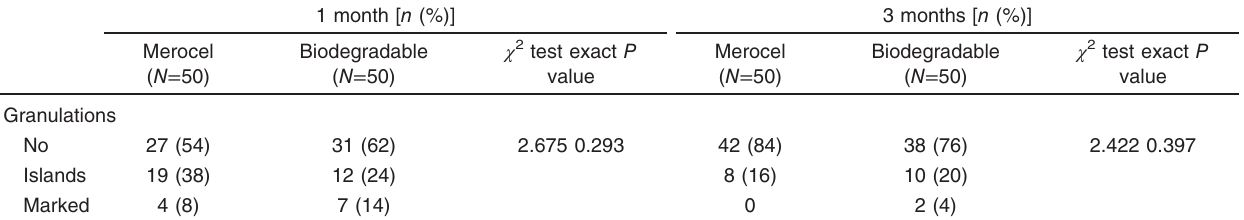
Table 3 Comparison between biodegradable and nondegradable sides regarding the granulation tissue formation at 1- and 3- month postoperatively